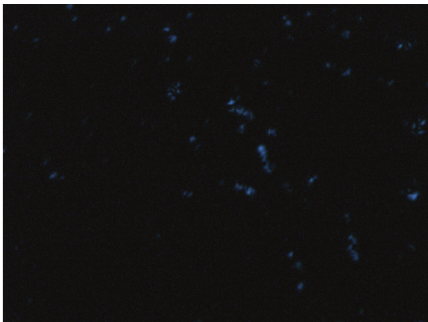
Figure 4: Optical image of PCL at the start of the isothermal crys- tallization (hot stage temperature = 45 ∘ C), 50x (image dimensions: 175 × 131.2 𝜇 m).